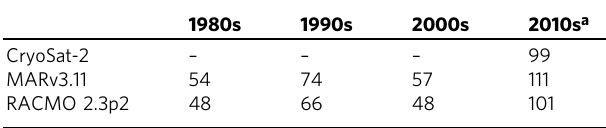
Fig. 4 Greenland Ice Sheet runoff and summer elevation change, 1980 – 2020. (bottom) Runoff from the Greenland Ice Sheet derived from RACMO2.3p2 20 (orange, 1980 – 2019) and MARv3.11 22 (red, 1980 – 2020) regional climate models, and CryoSat-2 satellite observations (blue, 2011 – 2020, shaded region represents the estimated 1 σ uncertainty). Vertical lines mark consecutive decades during the 40-year period (Table 1). (top) May – August elevation changes in the ablation zone of the Greenland Ice Sheet, divided into its principal drainage basins 39 , derived from the Institute for Marine and Atmospheric Research Utrecht Firn Densi fi cation Model (IMAU-FDM) (1980 – 2010) and CryoSat-2 satellite observations (2011 – 2020). Table 1 Greenland runoff variability. The standard deviation of Greenland Ice Sheet runoff (in Gt/yr) per decade between 1980 and